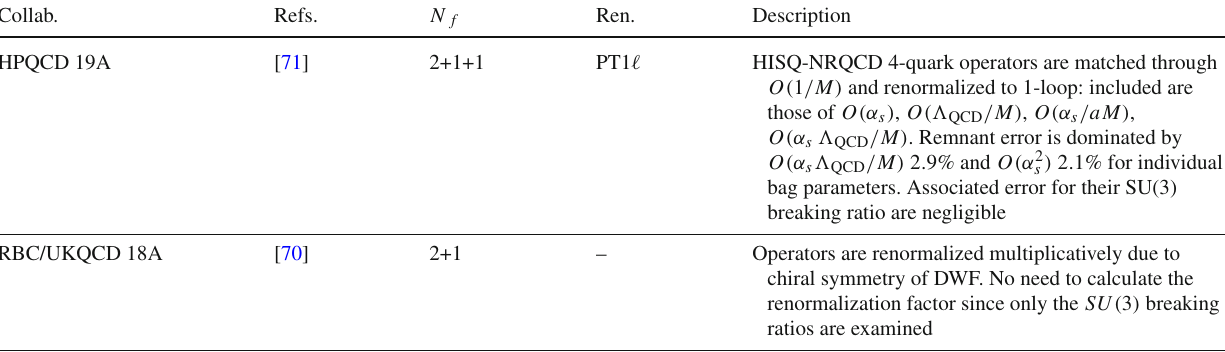
Table 153 Operator renormalization in determinations of the neutral B -meson mixing matrix elements